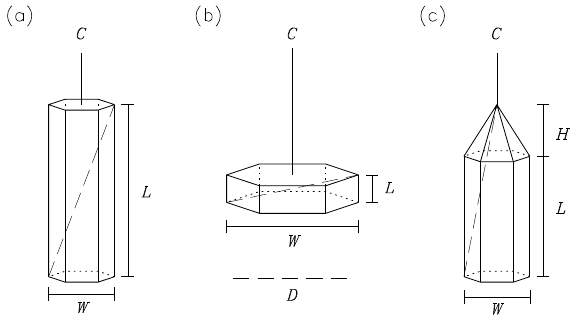
Figure 1. Idealized models of (a) column, (b) plate, and (c) bullet. The length ( L ), width ( W ), bullet tip height ( H ), and c axis are shown. A maximum dimension ( D ) is indicated with a long-dash